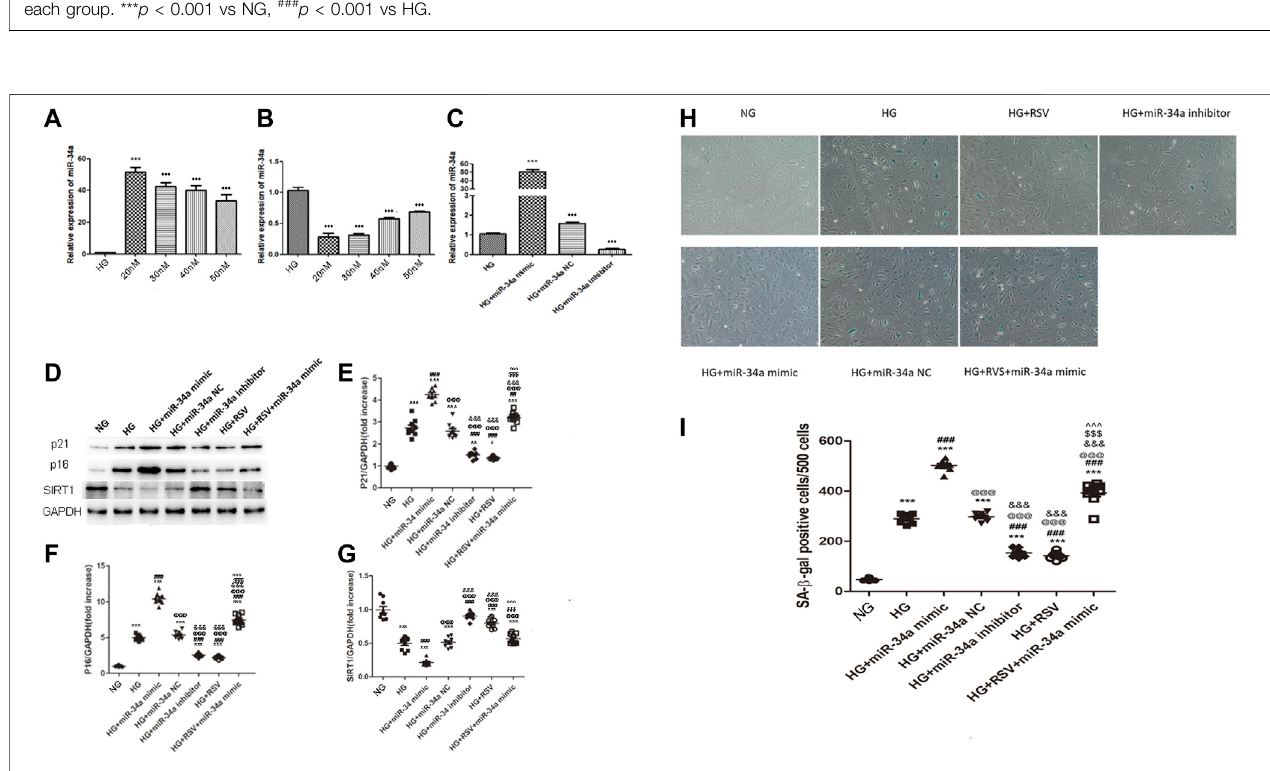
FIGURE3| RSVtreatment reducesBMSCssenescenceunderhyperglycemic conditionsbyregulatingmiR-34aexpression (A – C) QuantitativeRT-PCRwasused to determine the optimal transfection concentration of miR-34a mimic and inhibitor of different concentrations. *** p < 0.001 vs HG. (D – G) Western blot analysis shows theexpressionofSIRT1andsenescence-relatedproteinsP21andP16ineach.groupofcells.Eachcolumnrepresentsmean ± SDfromthreeindependentexperiments. ** p ＜ 0.01,*** p ＜ 0.001vsNG. ### p ＜ 0.001vsHG. @@@ p ＜ 0.001vsHG+miR-34amimic. &&& p ＜ 0.001vsHG+miR-34aNC. $$$ p ＜ 0.001vsHG+miR-34a inhibitor. ^^^ p ＜ 0.001 vs HG + RSV. (H,I) SA- β -galactosidase staining is used to judge the senescence degree of each group of cells. *** p ＜ 0.01, *** p ＜ 0.001 vs NG. ### p ＜ 0.001 vs HG. @@@ p ＜ 0.001 vs HG + miR-34a mimic. &&& p ＜ 0.001 vs HG + miR-34a NC. $$$ p ＜ 0.001 vs HG + miR-34a inhibitor. ^^^ p ＜ 0.001 vs HG + RSV.